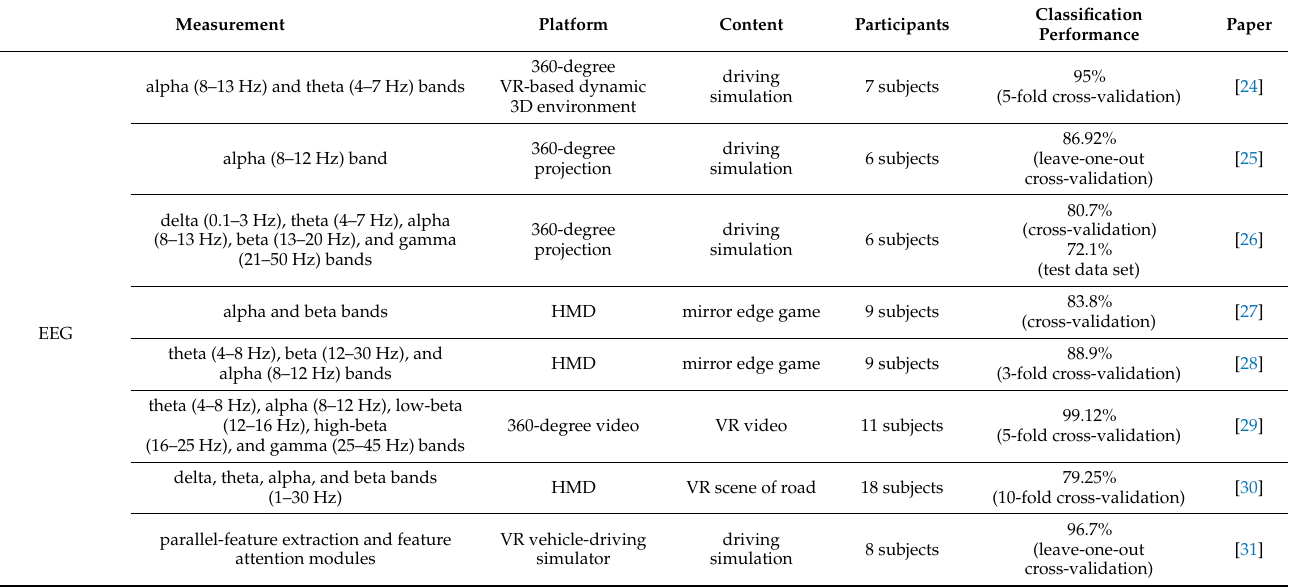
Table 1. Summary of MS measurement